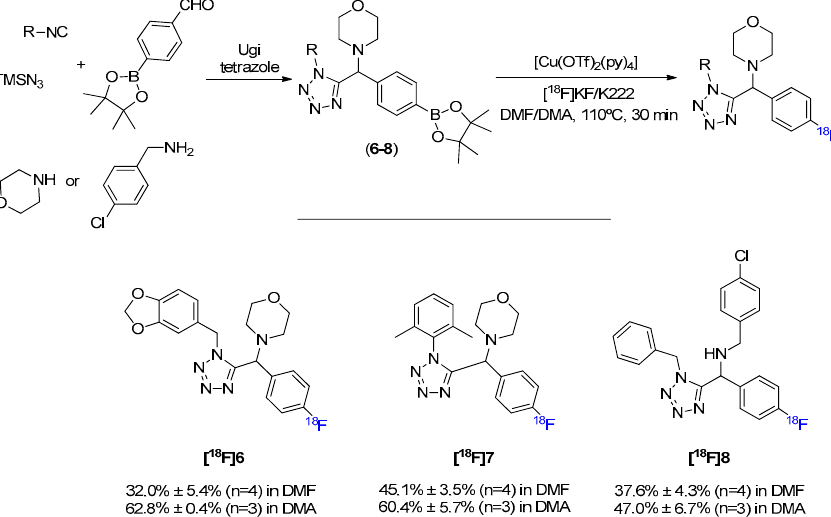
Scheme 4. General MCR synthesis and 18 F-fluorination of tetrazole scaffold.